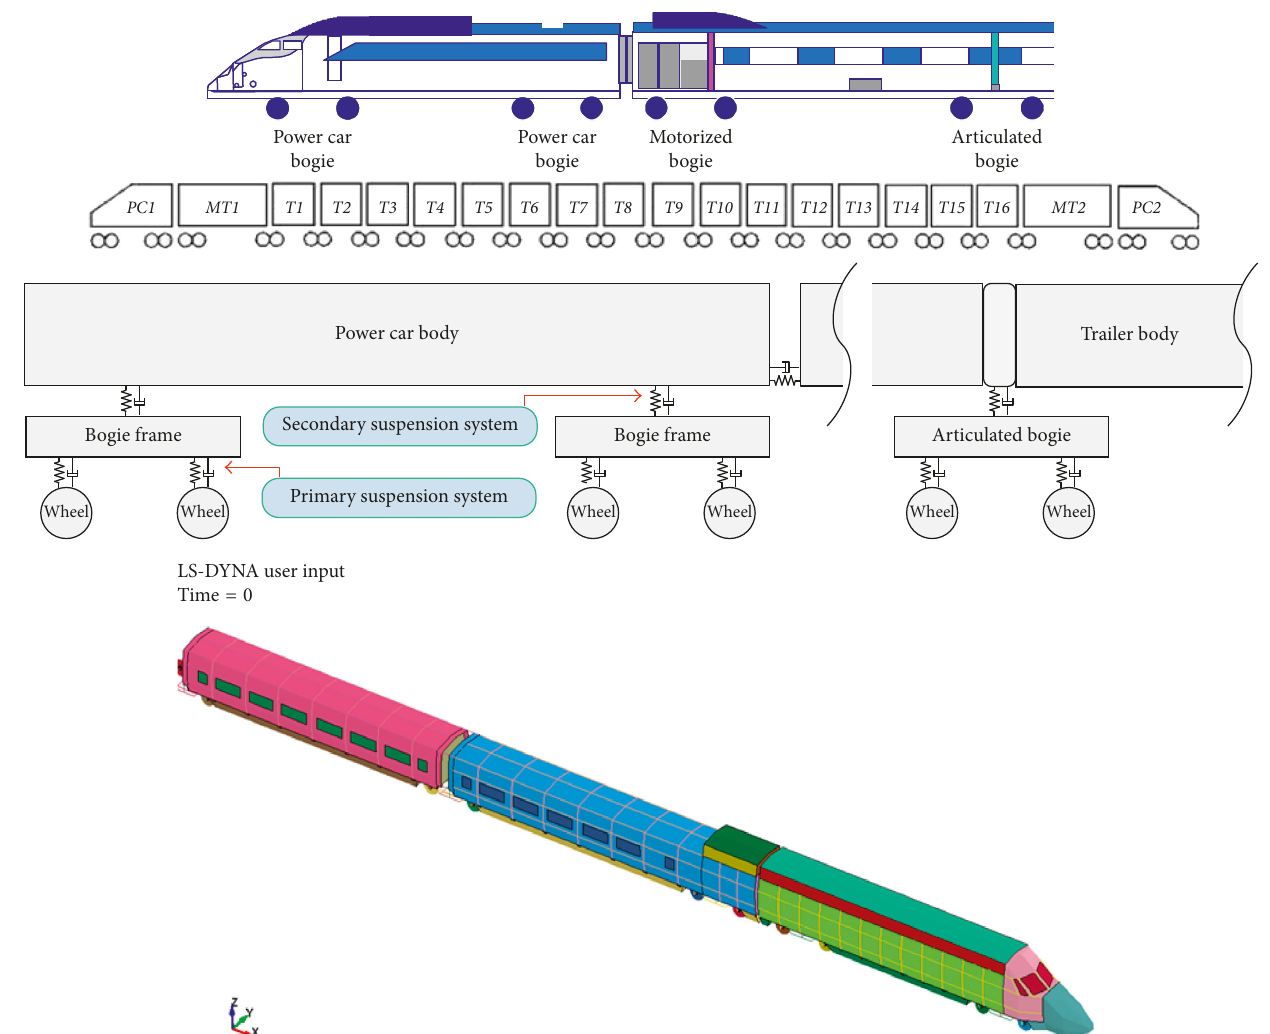
Figure 1: Model concept of